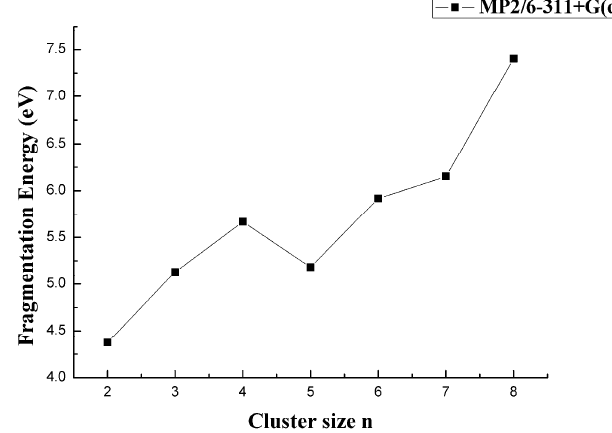
Figure 8. Size dependence of the fragmentation energy of CaB n (n = 1–8) clusters.